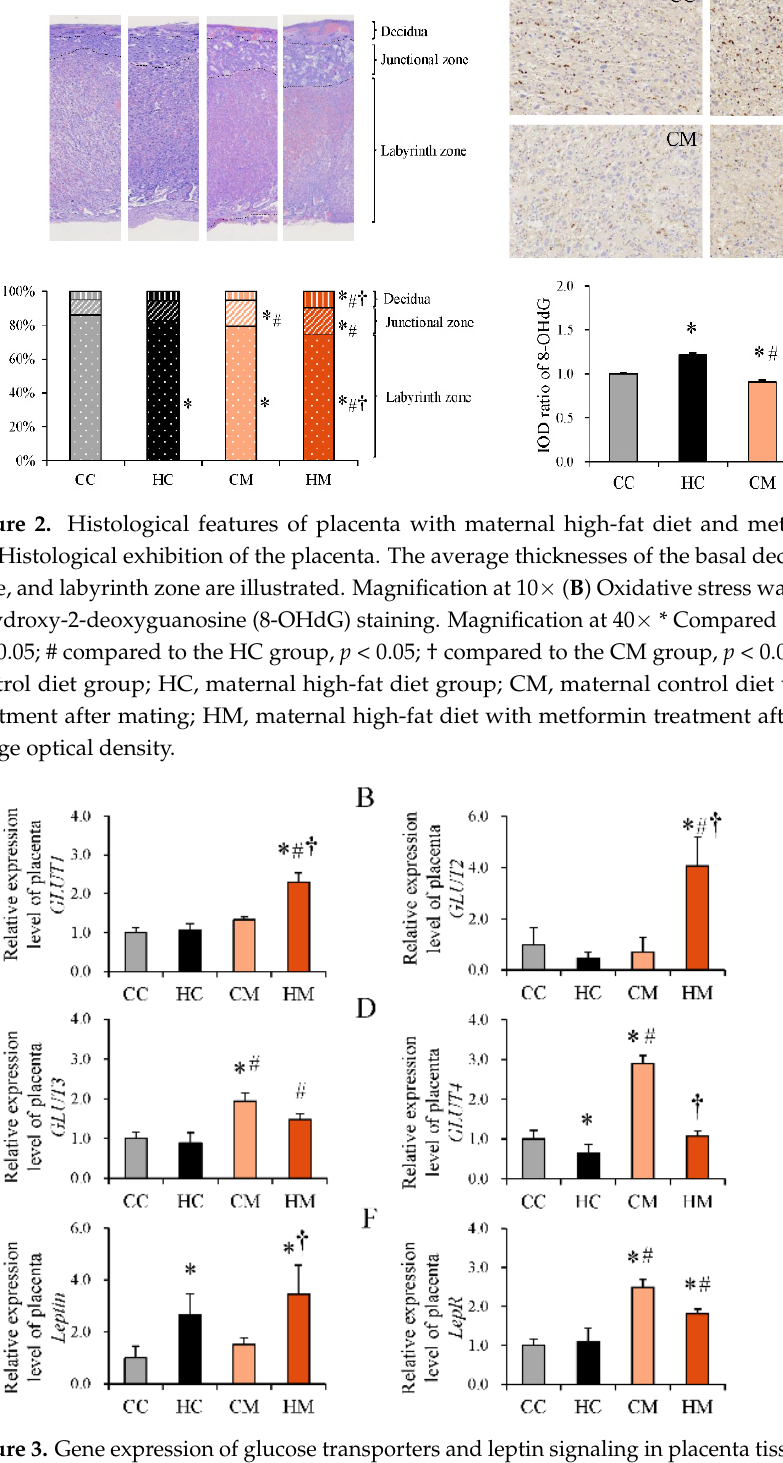
Figure 3. Gene expression of glucose transporters and leptin signaling in placenta tissue. ( A ) GLUT 1, ( B ) GLUT 2, ( C ) GLUT 3, ( D ) GLUT 4, ( E ) leptin, and ( F ) leptin receptor mRNA expression in the placenta tissue of rats administered a maternal control diet (CC), maternal high-fat diet (HC), maternal control diet with metformin treatment (CM), or maternal high-fat diet with metformin treatment (HM). * Compared to the CC group, p < 0.05; # compared to the HC group, p < 0.05; † compared to the CM group, p < 0.05. Abbreviation: GLUT, glucose transporter; LepR, leptin